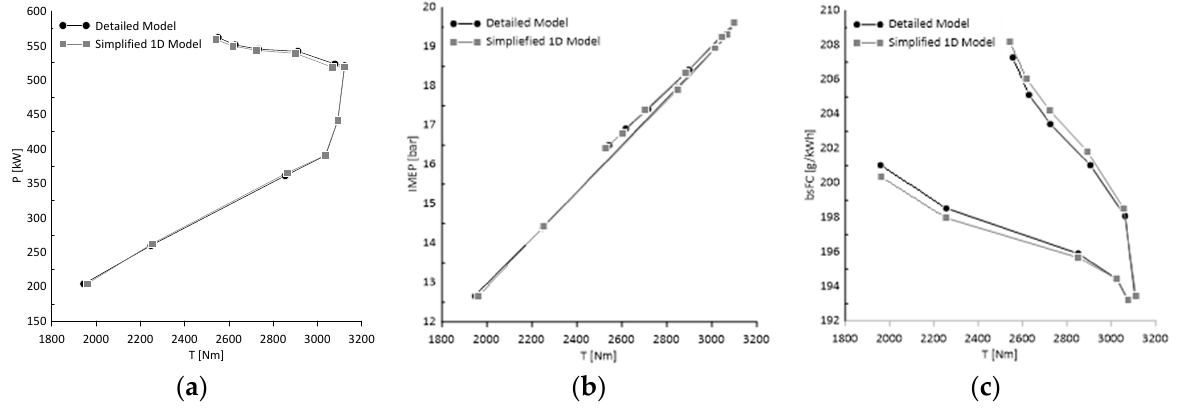
Figure 7. ( a ) Power, ( b ) IMEP, ( c ) bsFC Comparison.